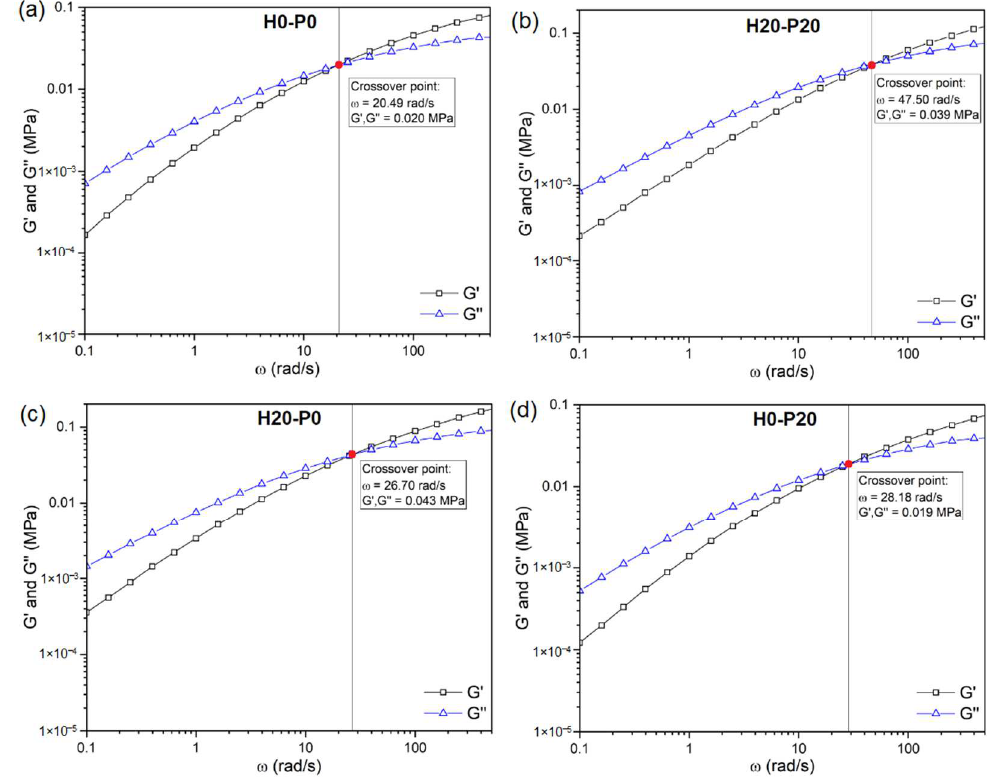
Figure 1. Results of frequency sweep tests on different compositions with the indication of the cross-